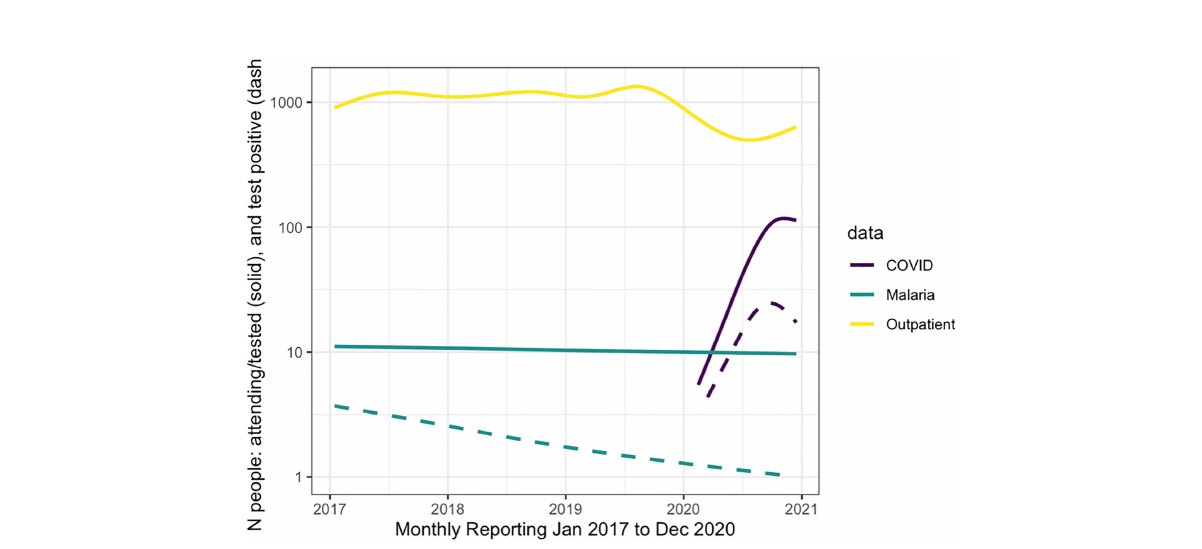
FIGURE 2 The reported number of people attending the outpatient department (yellow line), for malaria (teal lines) and for COVID-19 (purple line) from January 2017 to December 2020. The solid lines show the number of people tested for each pathogen and the dashed line represents those who tested